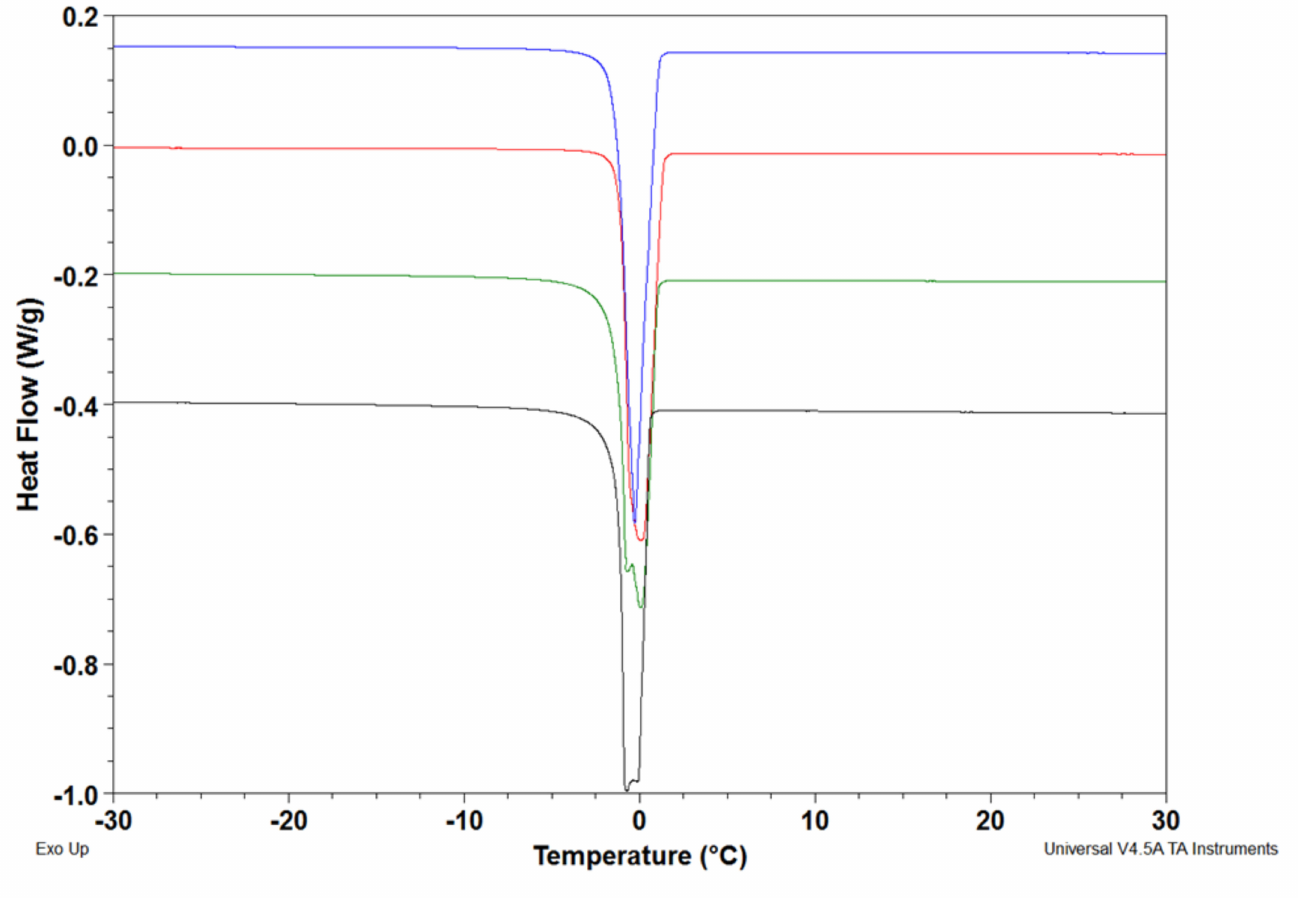
Figure 7. The DSC endothermic melting profile of frozen completely swollen hydrogels obtained with HA(270)-FA-HEG-CL - 20 (green), HA(270)-FA-HEG-CL - 40 (black), HA(270)-FA-HEG-CL - 10 (red), and HA(8.7)-FA-HEG-CL - 20 (blue). Table 3. WC % (% water content by TGA), Wtot (total water by TGA), Wnf (not freezing Water by DSC), and Wf (freezing Water by DSC) % fW: percentage of freezing water. The subdivision